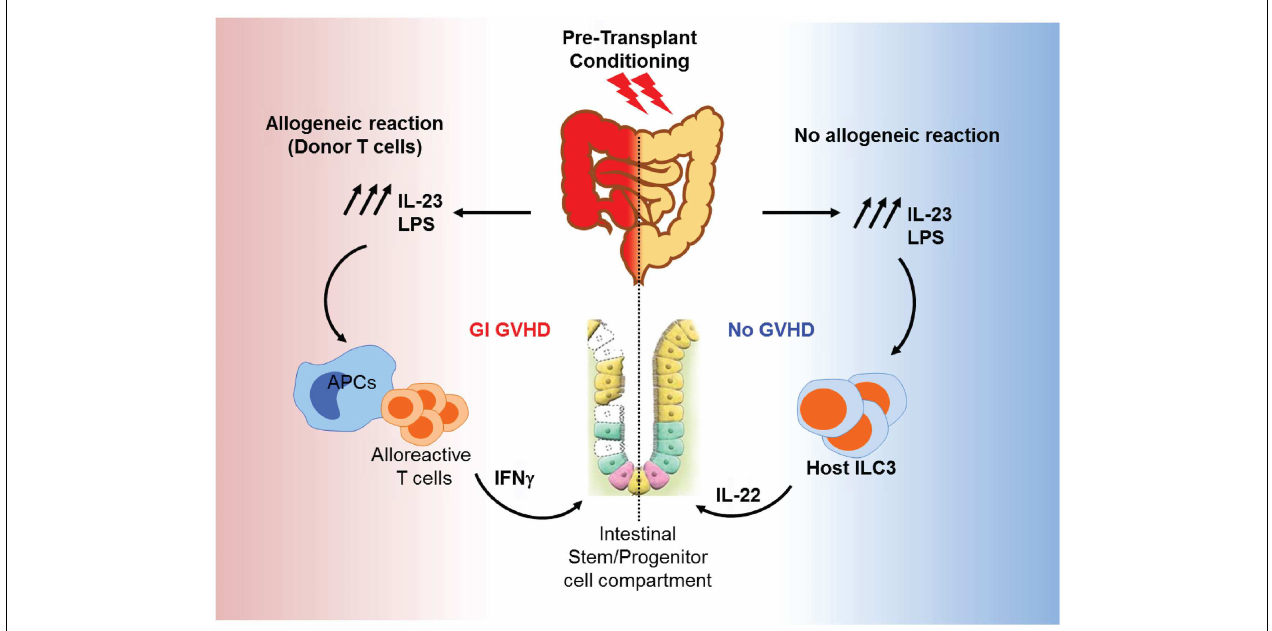
of the intestinal stem cells.This leads to more gut injury and GI GVHD (left). In the absence of alloreactive donorT-cells, IL-23 stimulates ILC3 to release IL-22, which protects the intestinal stem-cell compartment and promotes gut recovery from conditioning damage